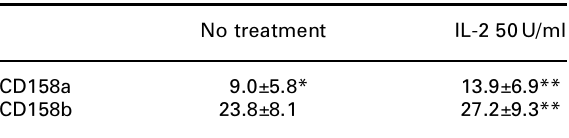
Table 3. The change of the expression of KIRs when enriched NK cells are stimulated by